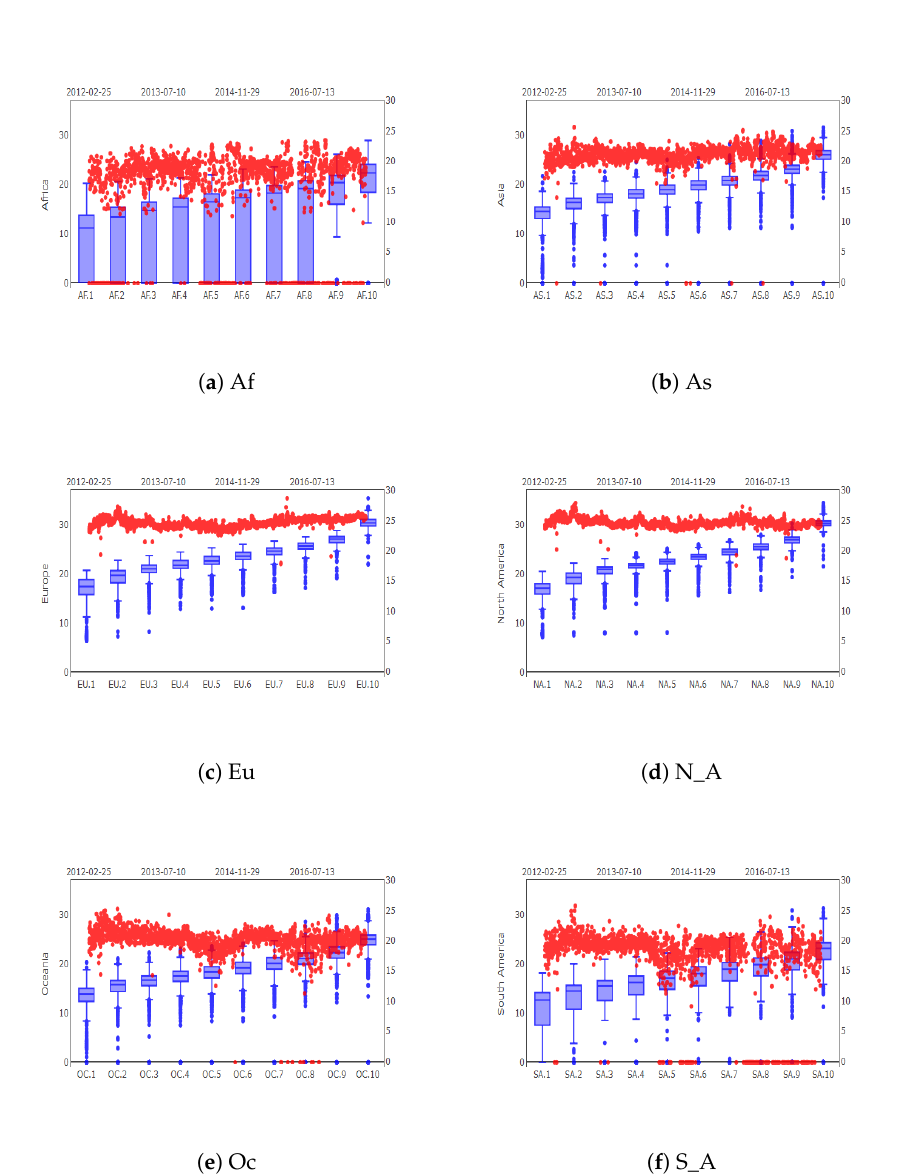
Figure 1. Daily volume transactions (expressed in logarithms) of the 10 groups displayed as boxplots, where the left boxplot represents the first group and the right one the ten groups of the respective continent. The scatter plot displays the accumulated log transaction size of the 10 groups. The time period goes from 25 February 2012 until 17 July 2017 in all 6